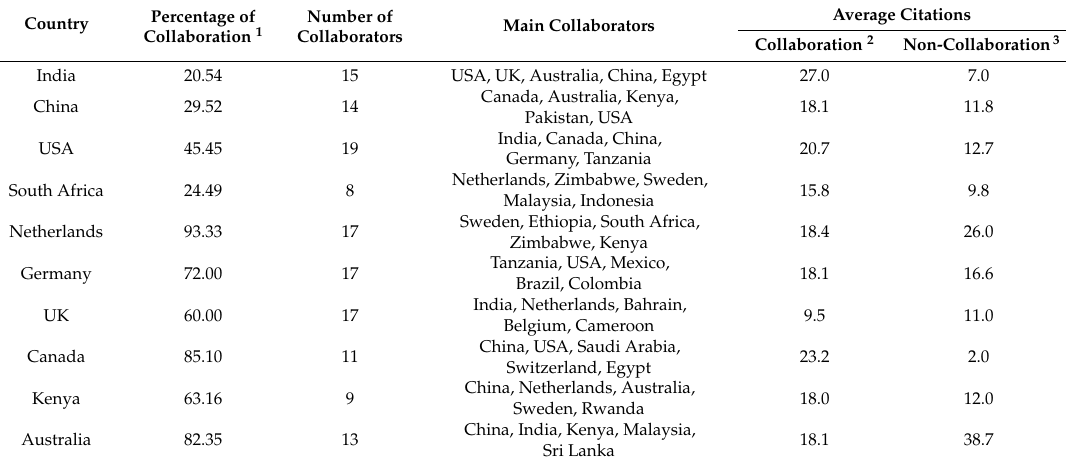
Table 4. International collaboration of the most active countries in RWHI research.